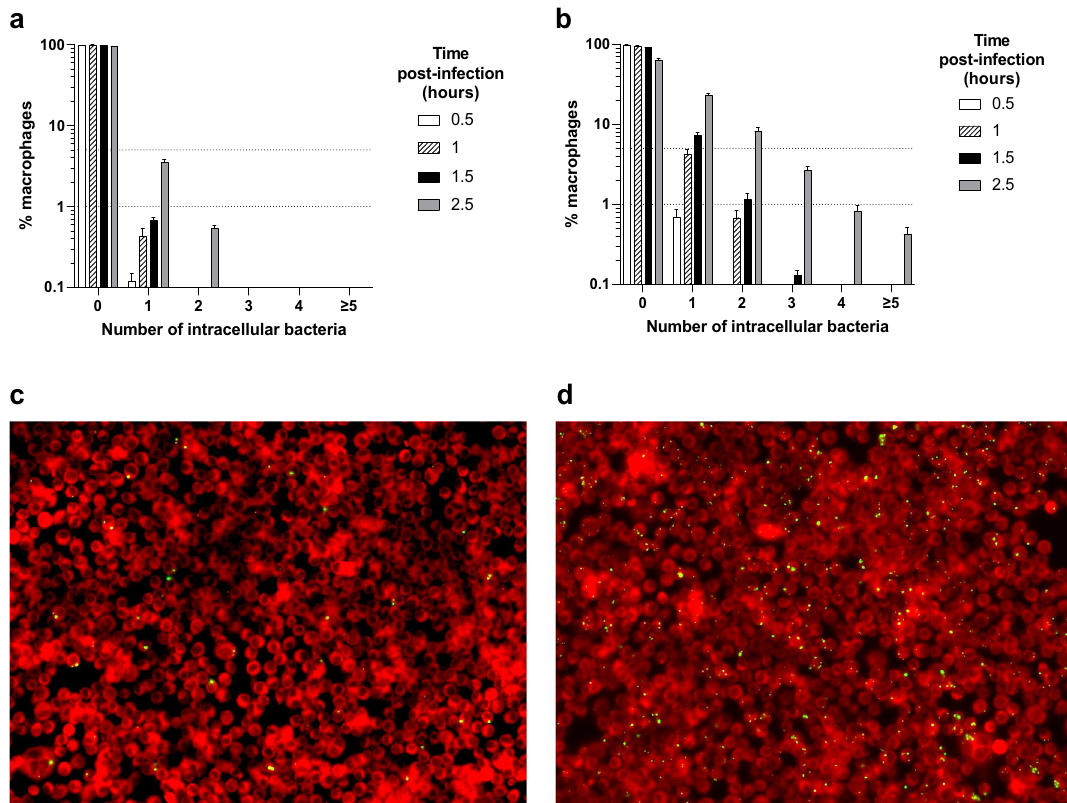
Figure 2. Phagocytosis of S. aureus by macrophages over time. ( a – b ) Percentage (%) of RAW264.7 macrophages with different numbers of internalised bacteria after incubation with S. aureus for 0.5 h (white bars), 1 h (shaded bars), 1.5 h (black bars) and 2.5 h (grey bars). Bars represent mean percentage ± SEM ( n = 3), dotted horizontal lines show 1% and 5%. ( a ) S. aureus MOI 5; ( b ) S. aureus MOI 50. ( c – d ), representative images of RAW264.7 macrophages (red) with internalised bacteria after incubation with GFP S. aureus (green) for 2.5 h: ( c ) MOI 5 S. aureus , ( d ) MOI 50 S. aureus (scale bars 50